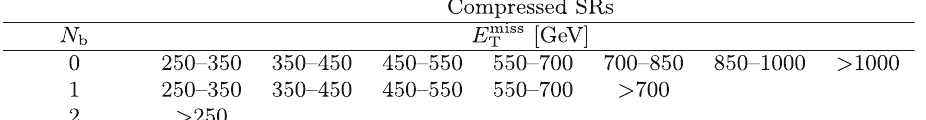
Table 6 The categorization in H T , 12 and m CT for the SRs targeting noncompressed signal scenarios, and in N b and E miss for those targeting compressed signal